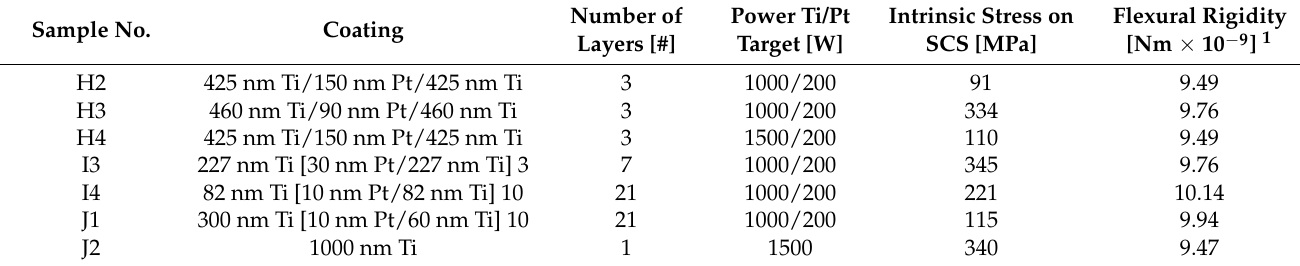
Table 1. Coating designs, sputter process parameters, and material properties of the diaphragms considered for the present study. For all sputter runs, argon at 55 sccm (0.9 mTorr) was used as a sputtering gas.